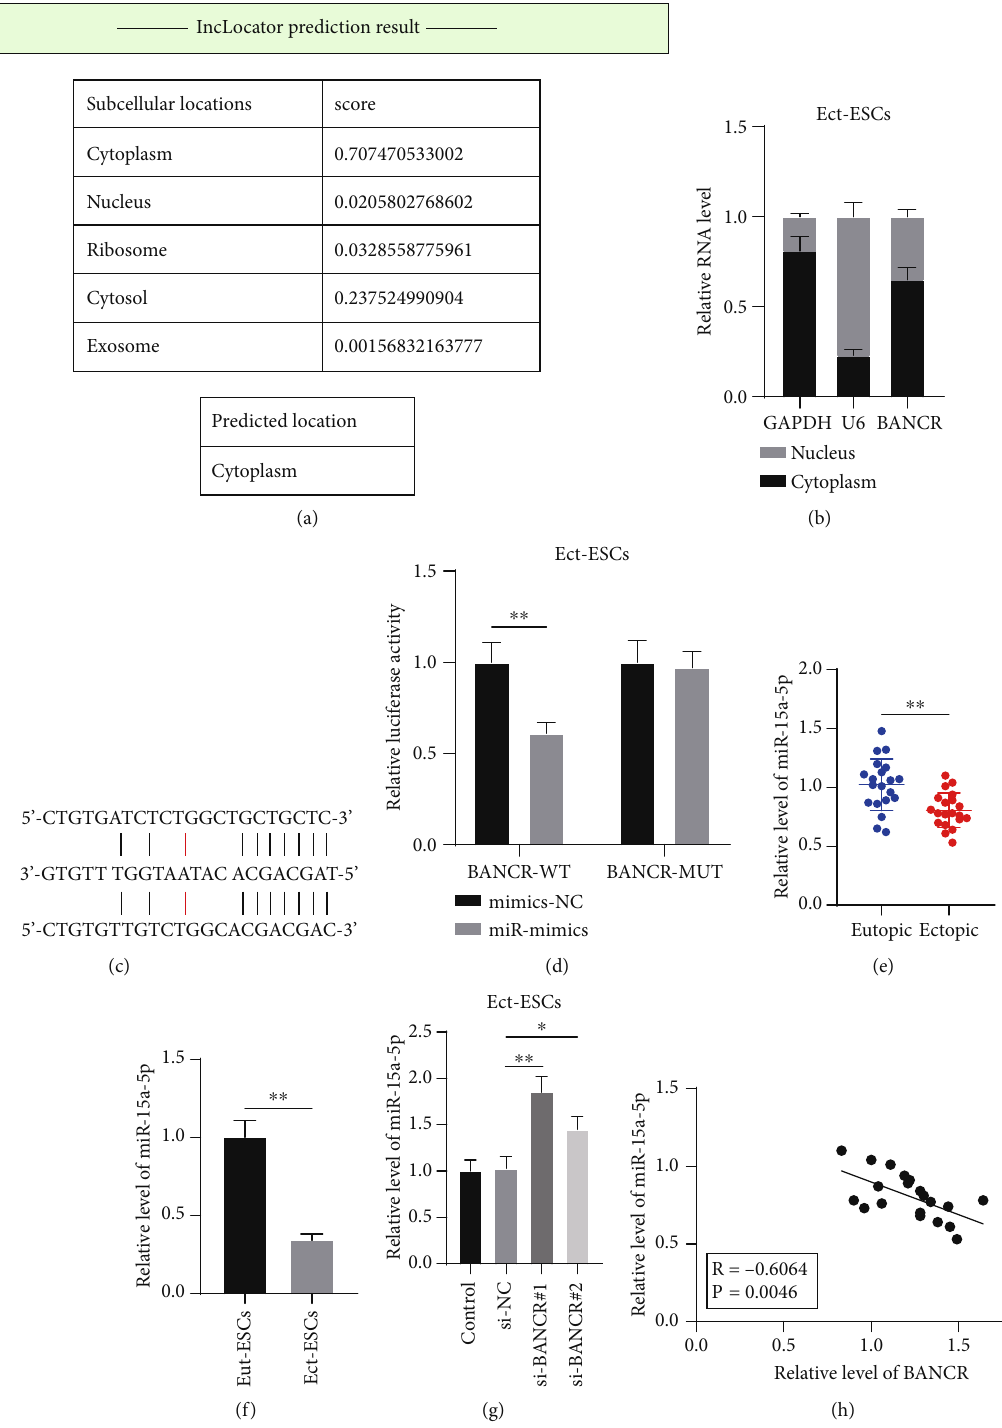
Figure 2: LncRNA BANCR targets and inhibits miR-15a-5p . (a) Subcellular localization of lncRNA BANCR was predicted on the lncLocator database; (b) Subcellular localization of lncRNA BANCR was testi fi ed by the subcellular fractionation assay; (c) Binding sites of lncRNA BANCR to miR-15a-5p were predicted on the RNA22 database; (d) Binding relationship between lncRNA BANCR and miR-15a-5p was veri fi ed by the dual-luciferase assay; (e) miR-15a-5p expressions in eutopic and ectopic endometrial tissues ( N = 20 ) were determined by RT-qPCR; (f) — (g) miR-15a-5p expressions in Eut-ESCs and Ect-ESCs were determined by RT-qPCR; (h) Correlation between lncRNA BANCR and miR-15a-5p in ectopic endometrial tissues of EM patients ( N = 20 ) was analyzed using Pearson correlation analysis. Cell experiments were performed thrice independently. Data in fi gures (b), (d), (f), and (g) were formalized as mean ± SD. Data in fi gure (d) were analyzed using two-way ANOVA, data in fi gures (e) – (f) were analyzed using the t test, and data in fi gure (g) were analyzed using one-way ANOVA, followed by Tukey ’ s multiple comparison test. ** P < 0 : 01